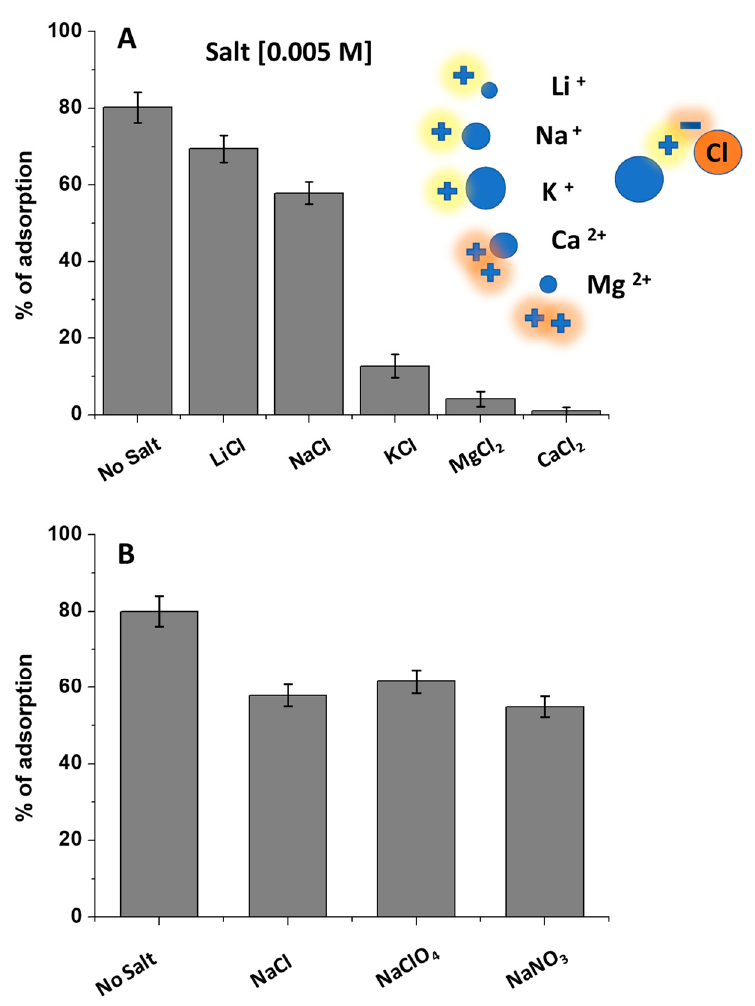
Figure 4. ( A ) Percentage of DCF adsorption onto chitosan film (Film 2), at pH 5, (from a DCF solution 1.50 × 10 -5 M), in the presence of different salts, and ( B ) by changing the nature of the cation and anion. The adopted contact time was 120 min.